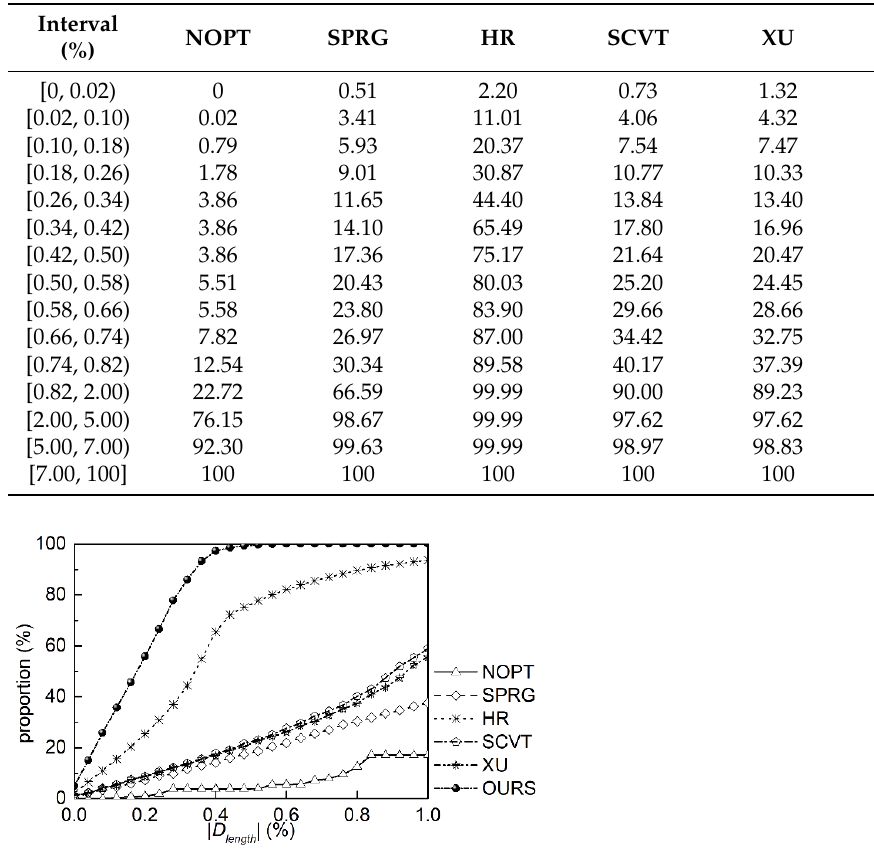
Figure 11. Because of higher cumulative proportion in OURS grid in a smaller interval, only a part of results with | D length | < 1.00% are demonstrated. Table 10. The cumulative proportion of | D length | of different grids (%).